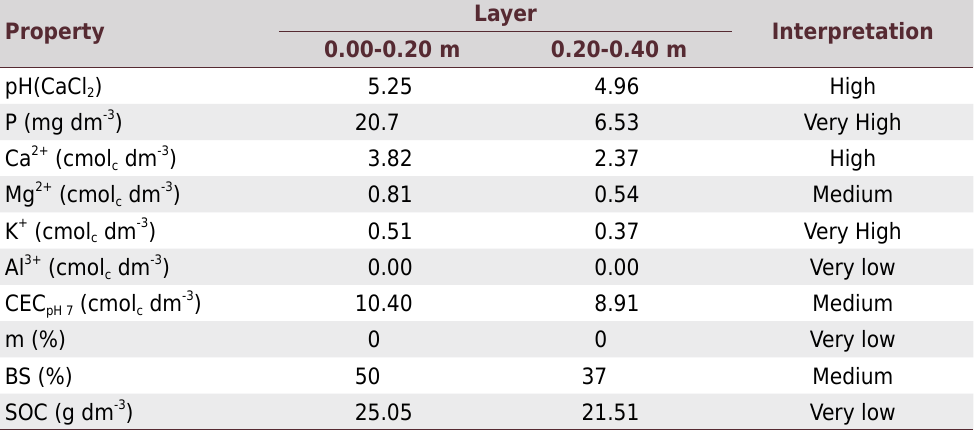
Table 1. Chemical properties of the Latossolo Vermelho distroférrico before implementation of the experiment and interpretation of the values for the surface layer (0.00-0.20 m) according to SBCS/NEPAR (2019)